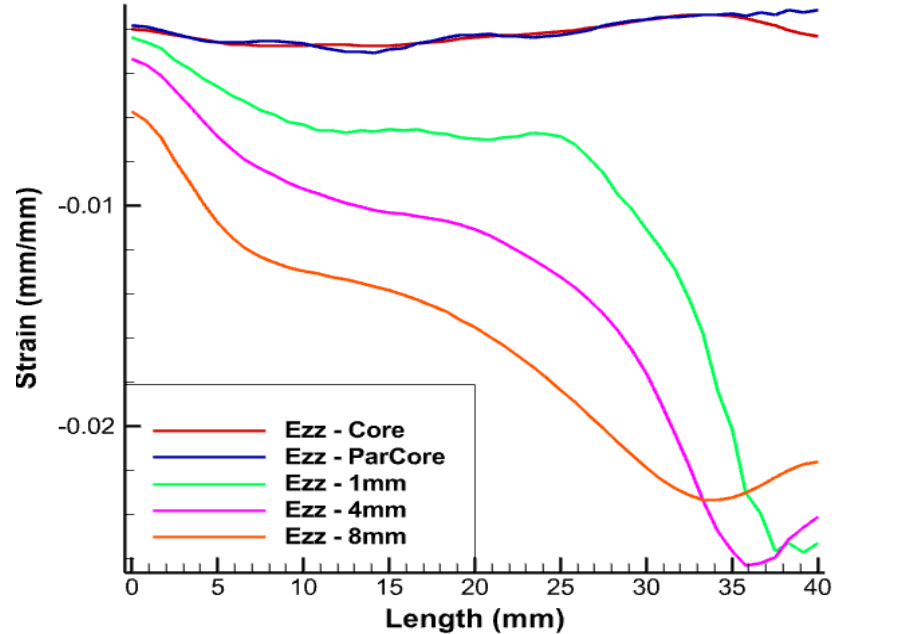
Figure 12. E zz strain for pure tension test